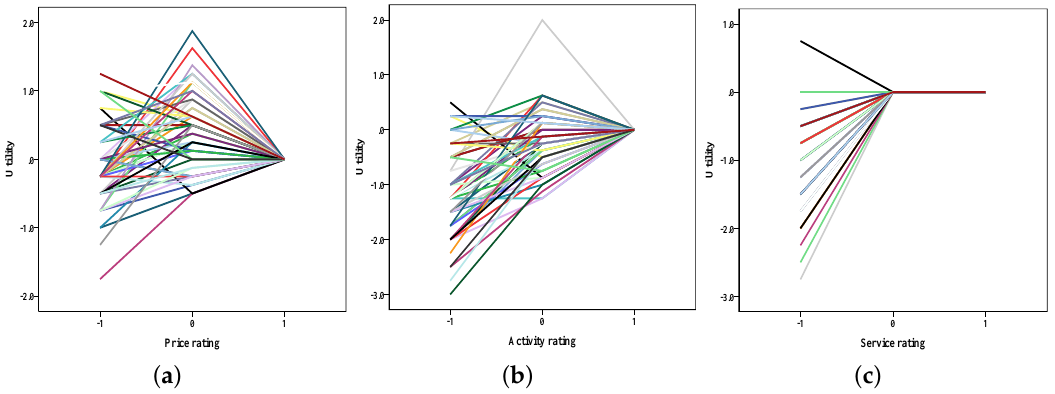
Figure 4. The utility plot of the attributes in Qingshan scenic spots (( a ) utility change with price rating; ( b ) utility change with activity rating; ( c ) utility change with service rating).